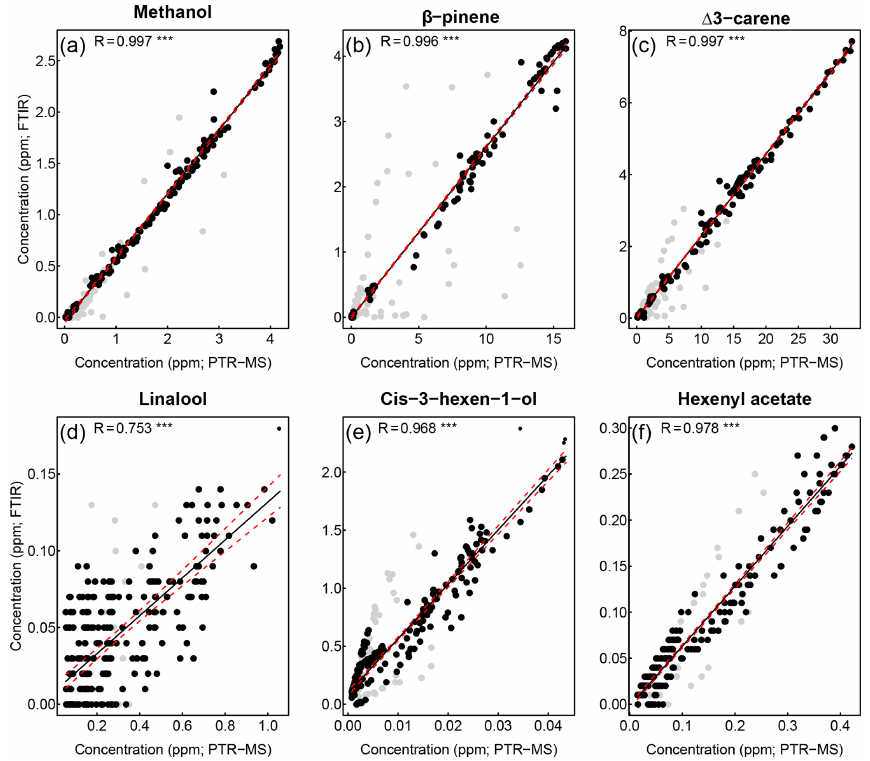
Figure 6. Correlation between FTIR- and PTR-MS-based measurements of VOC mixing ratios. Data points plotted in grey were excluded after rapid changes in the VOC mixing ratio. Asterisks indicate significant levels: * p < 0 . 05; ** p < 0 . 01; *** p < 0 .